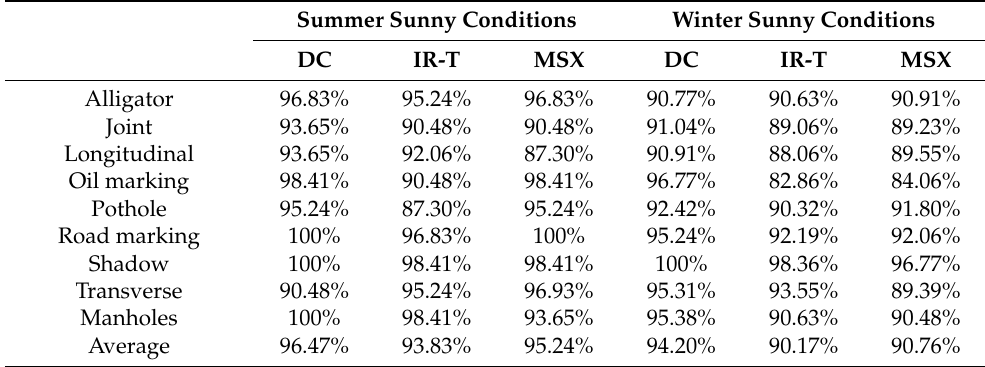
Figure 19. Precision measure. Table 6. Comparison of the performance of the different input data for each class. Summer Sunny